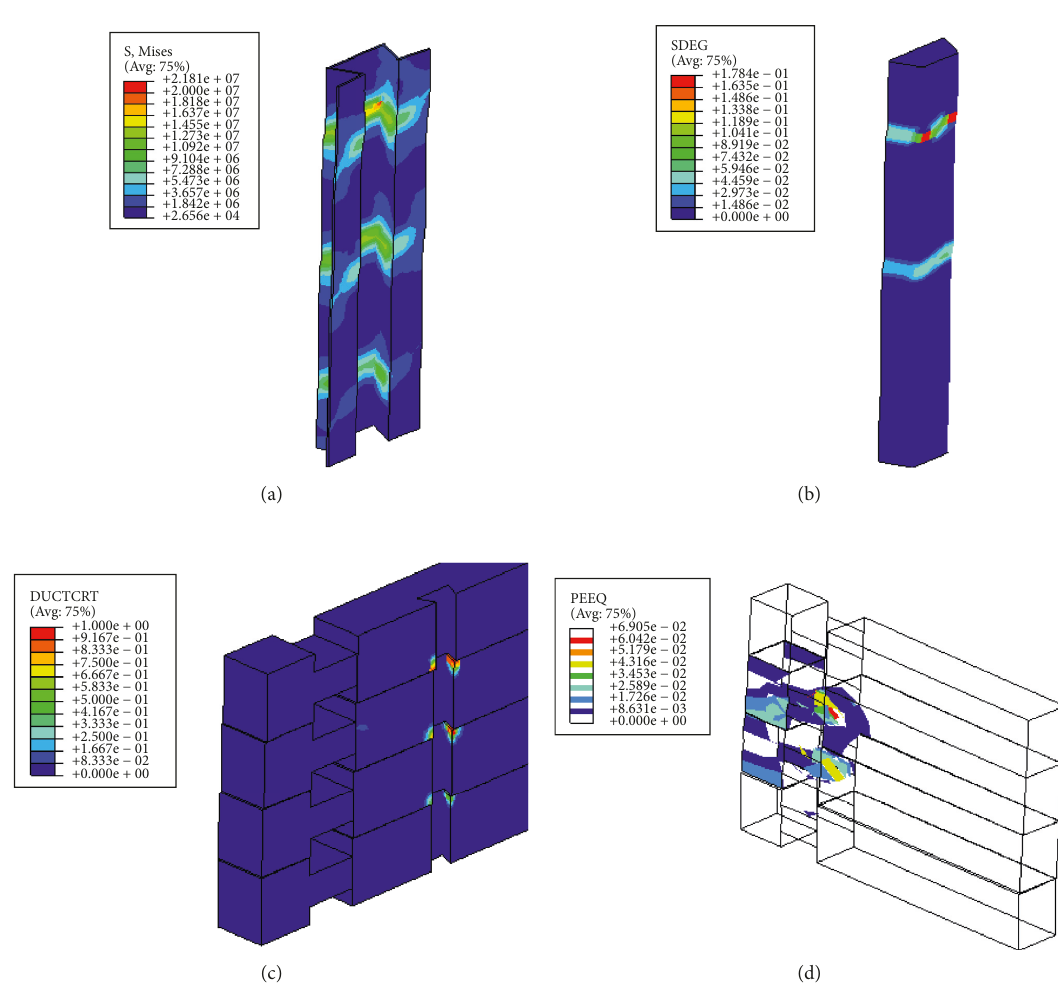
Figure 10: Damage propagation in the W02 components (ABAQUS). (a) Von Mises stresses in the steel dovetails (values in Pa), at a given displacement of 10mm for the top log, with corresponding damage scenario in the (b) hardwood profiles and (c) main logs (detail). (d) Crushing phenomena in orthogonal logs (carpentry joints), at a top log displacement of 25mm.